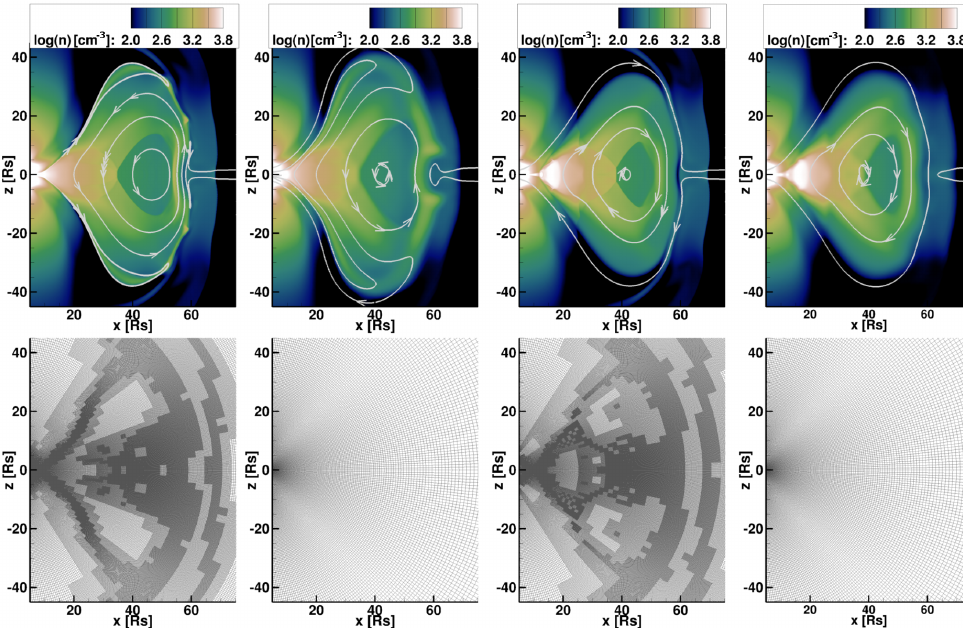
Figure 12. Top row shows logarithmic number density for normal and inverse CMEs. The first panel shows a normal CME ejected in a middle density background wind with with 4 levels of refinement, while the second panel shows the same normal CME but now no AMR was applied. The third and fourth panel show the same, but for an inverse CME. White lines represent selected magnetic field lines. The bottom row shows the grid of the same simulation at the same time step as the figure above it. All plots are made at 12.5 h after